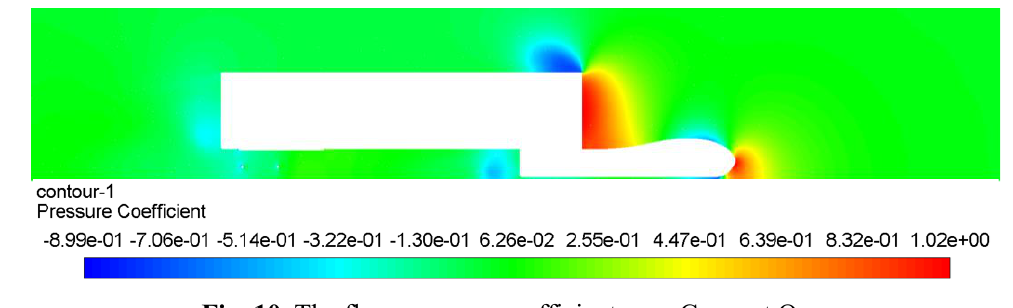
Fig. 10. The flow pressure coefficient over Concept One.